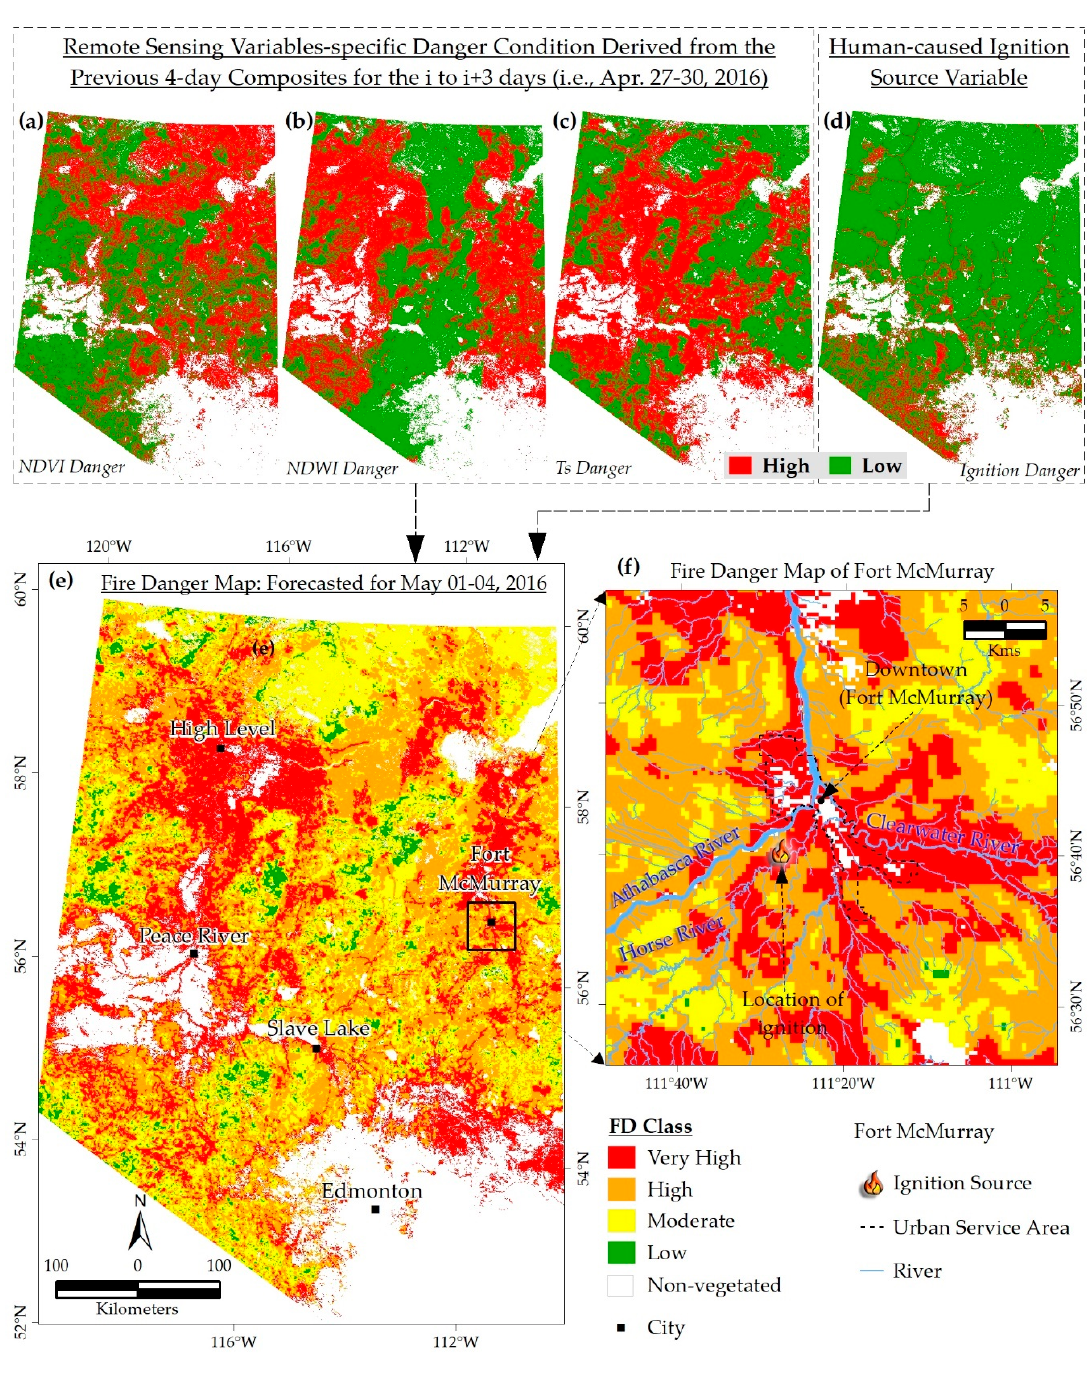
Figure 6. An example of the fire danger maps categorized into high and low FD classes that were produced on 01 May, 2016 by the RS-based four-day scale FFDFS model based on the individual variable specific danger conditions, i.e., NDVI ( a ), NDWI ( b ), 𝑇𝑠 ( c ), and human-caused ignition source ( d ) over the previous four days (i.e., 27–30 April 2016). These maps were combined to produce a final forest fire danger map to forecast the danger conditions over the next four days (i.e., 01–04 May 2016) in four different danger categories, i.e., very high to low ( e ). A case study location of Fort McMurray, Alberta that suffered the devastating 2016 Horse River Wildfire started on 01 May 2016, illustrating the forecasted forest fire danger conditions generated by RS-based four-day scale FFDFS model during the event ( f ).